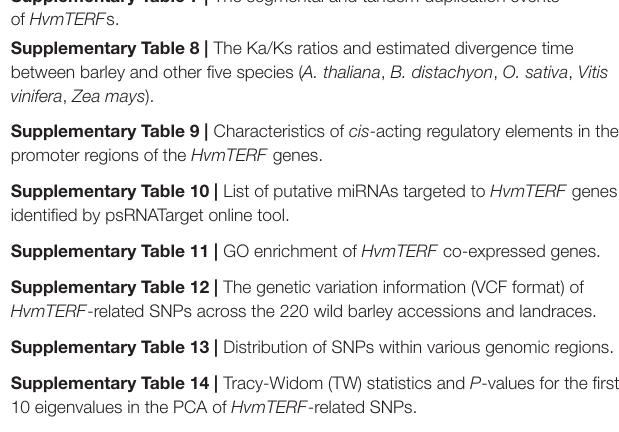
( ∗ ) indicates 0.05 significance level. Double asterisk ( ∗∗ ) indicates 0.01 significance level.